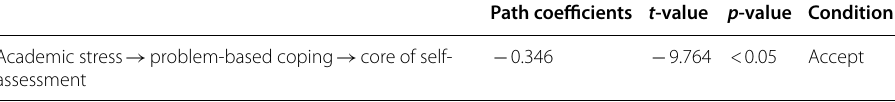
Significant at the level of 0.01 ( p <